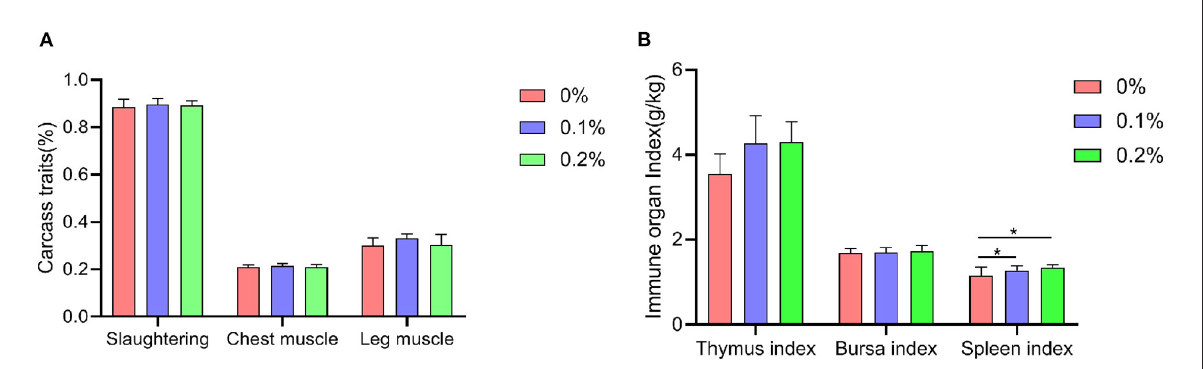
FIGURE2 Effect of PC addition to diets on the carcass traits and immune organ index in AA + broilers. (A) Carcass traits. (B) Immune organ index. “*” means indicates a significant difference ( P < 0.05). No “*” indicates that the difference is not significant ( P > 0.05).